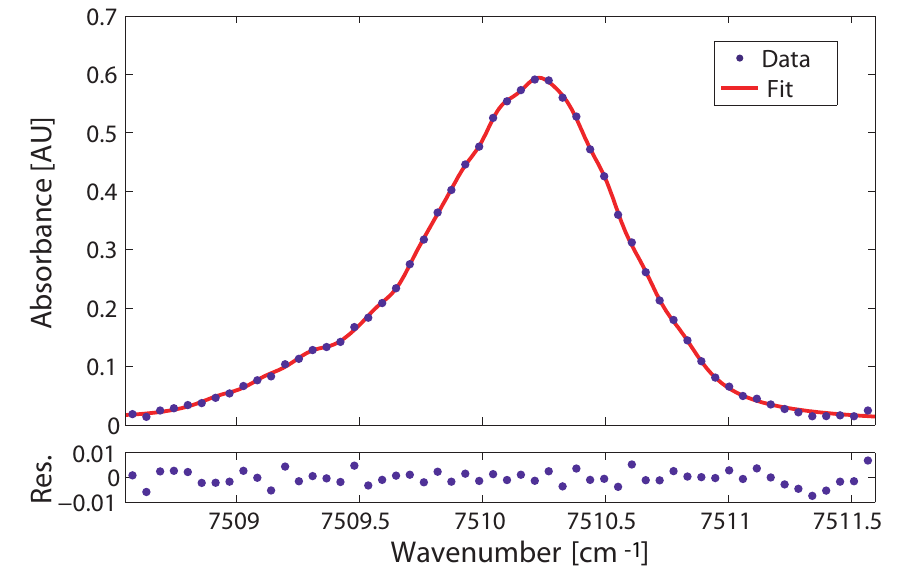
Figure 8. Upper panel: 36-transition Lorentzian fit (solid curve) and experimental ab- sorbance data (dots) for the Q-branch at room temperature, relative pressure of 1 bar and methane concentration of 18750 ppmv. The detection limit is 98 ppmv. Lower panel: Resid- uals of the